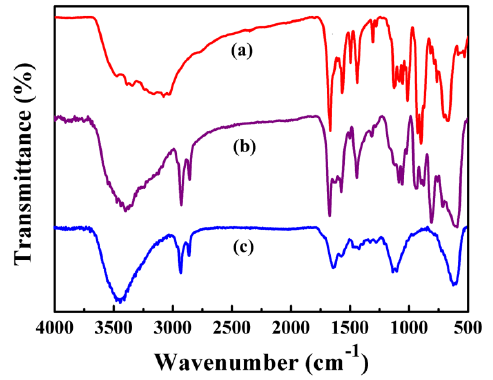
Figure 4. FTIR spectra of ( a ) POMs, ( b ) Fe 3 O 4 /Ag/POMs nanocomposites, and ( c ) Fe 3 O 4 /Ag